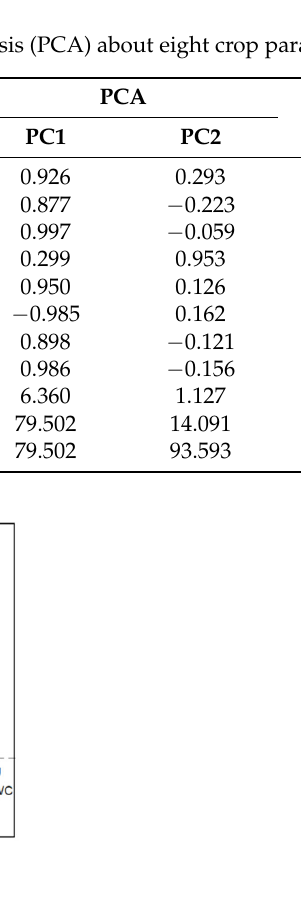
Figure 9. Sensitivity indexes under different management practice ( P n , photosynthetic rate; LAI, leaf area index; DU, developmental uniformity; DR, development rate; RE, rate of emergence rate; ST, soil temperature; DMW, dry matter weight; RWC, relative water content).